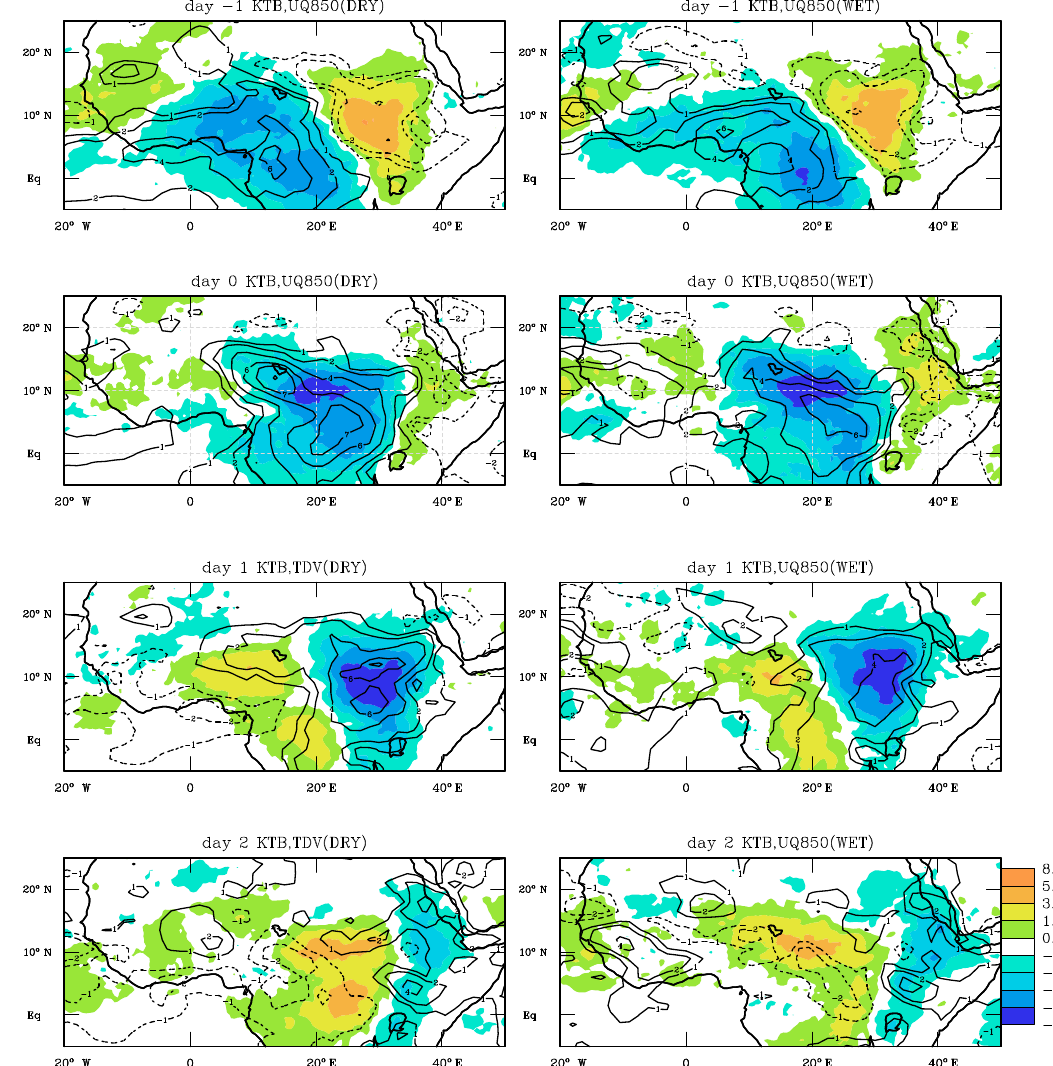
Figure 8. Kelvin wave regression composite anomalies of T B (shaded in K) and 850 hPa moisture flux by the zonal wind in dry years (left panels) and wet years (right panels) from day − 1 to day 2. Zonal moisture flux anomaly contours (±0.1, ±0.2, ±0.4, ±0.6, ±0.7, ±0.8 and ±0.10) × 10 − 6 ms − 1 .g.kg -1 .